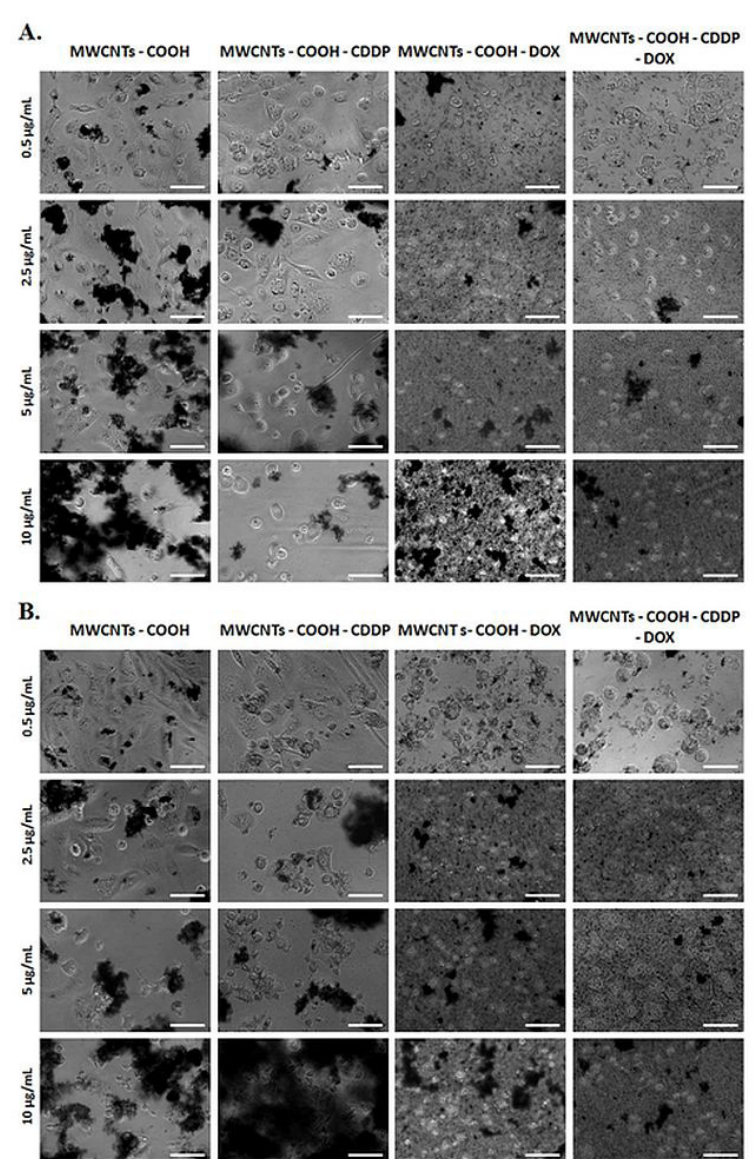
Figure 7. MDA-MB 231 cells exposed to four doses (0.5, 2.5, 5, 10 µg mL -1 ) of MWCNTs-COOH, MWCNTs-COOH-CDDP, MWCNTs-COOH-DOX and MWCNTs-COOH-CDDP-DOX for 24 (A) and 72 hours (B). Images were acquired by a bright field inverted microscope (Olympus IX7), objective 10X, using a CCD video camera COLORVIEW. The scale bar is the same for all images and corresponds to 25